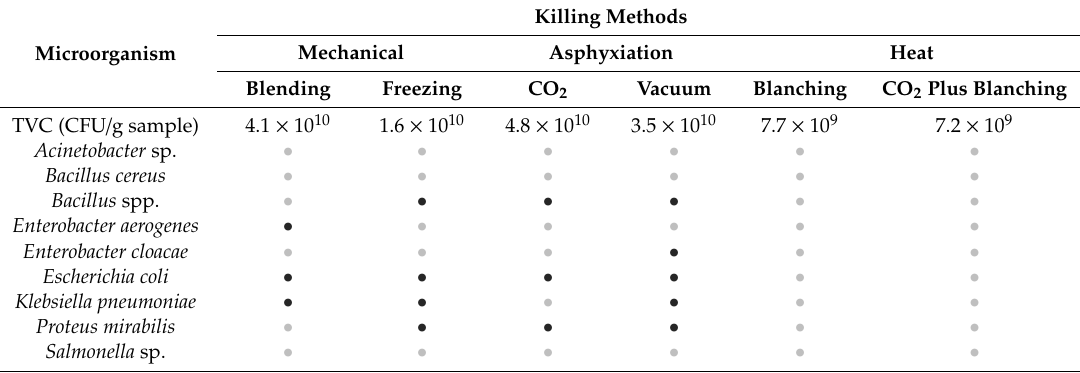
Table 1. Microbial load after killing black soldier fly (BSF) larvae from di ff erent killing methods.